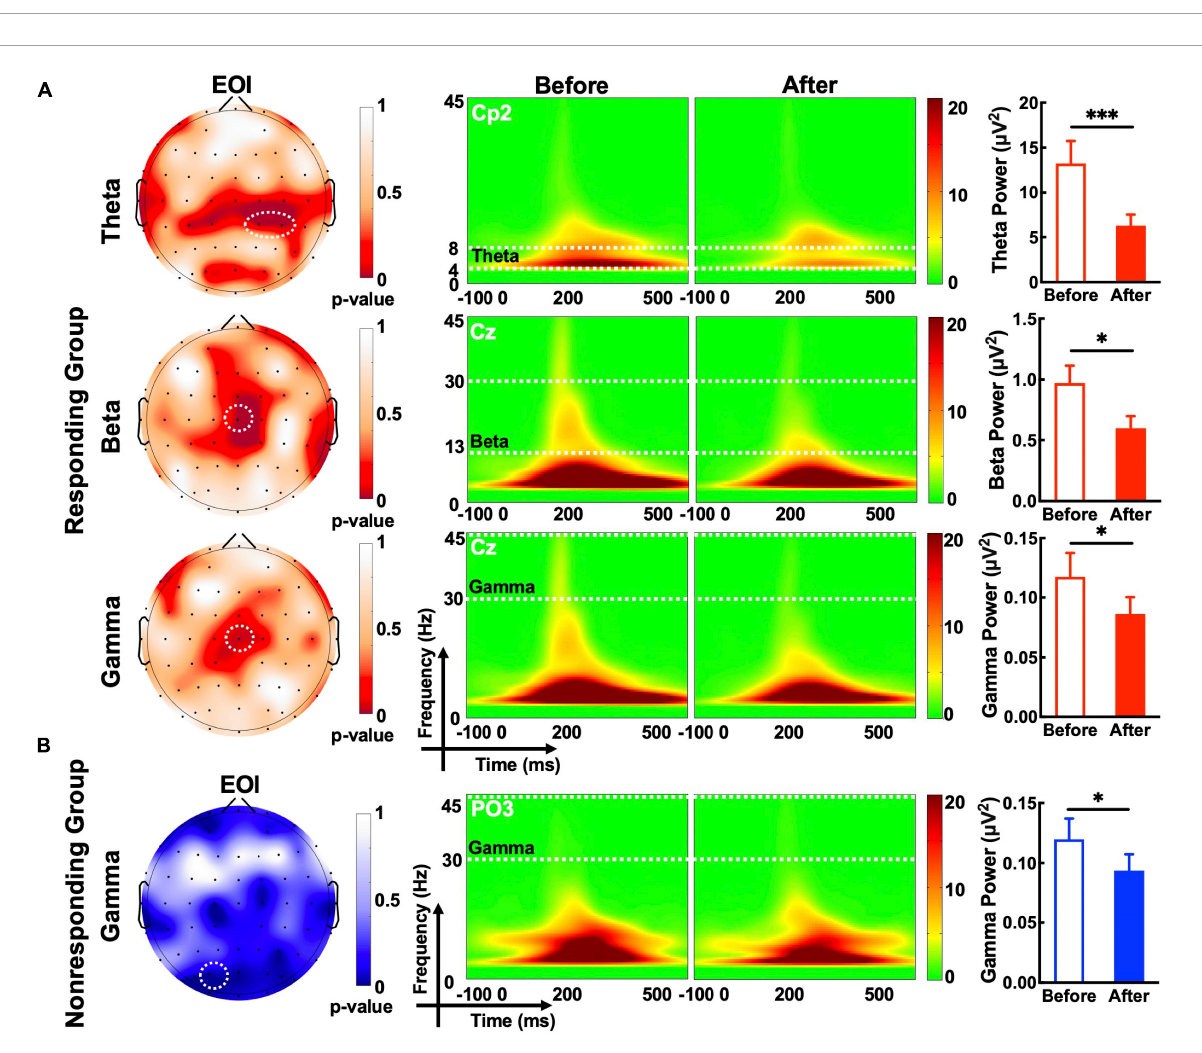
FIGURE4 The evoked oscillatory power in the electrode of interest (EOI). (A) The topographic map shows a significant difference in the p -value in the target frequency band before and after MIRT. White dashed circles denote electrodes with significant differences ( p -values corrected); Theta EOIs: Cp2 and Cp4; Beta EOI: Cz; Gamma (responding group) EOI: Cz; Gamma (non-responding group) EOI: PO3. (B) The time-frequency plot and histogram show the target frequency band power recorded from EOI before and after MIRT. ∗ p < 0.05, ∗∗∗ p < 0.001 with